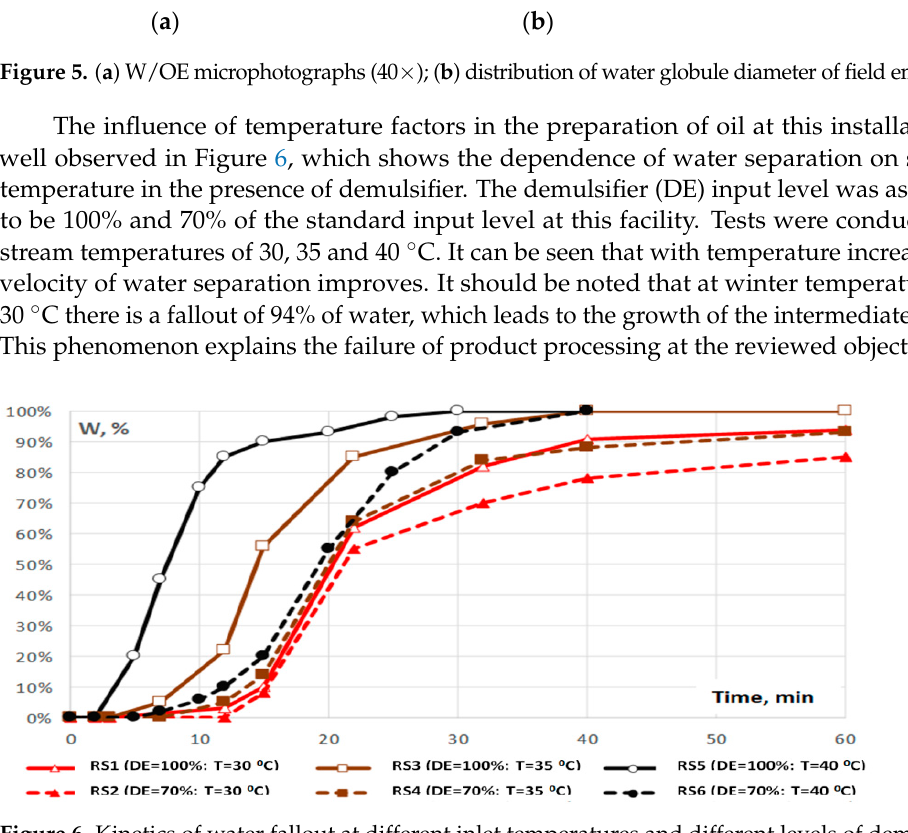
Figure 5. ( a ) W/OE microphotographs (40×); ( b ) distribution of water globule diameter of field emulsion.